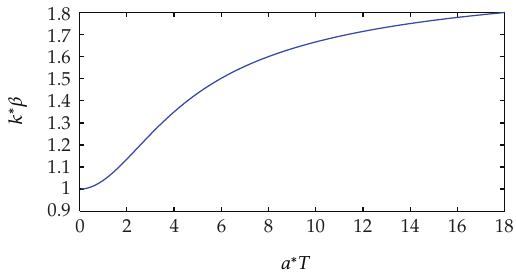
Figure 3: Estimates of upper bounds for kβ for the second-order PWM feedback system of Example 4.1.